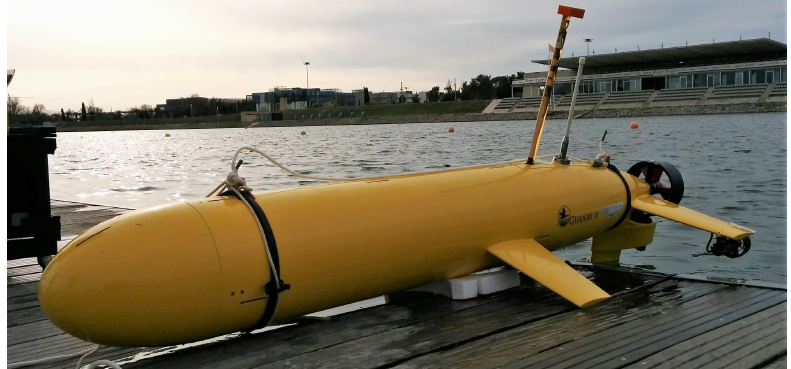
Figure 2. The Guanay II AUV [31] docked at the SARTI (Universitat Politecnica de Catalunya (UPC)) harbor facilities. Image taken during field tests at the Olympic Canal in Castelldefels.